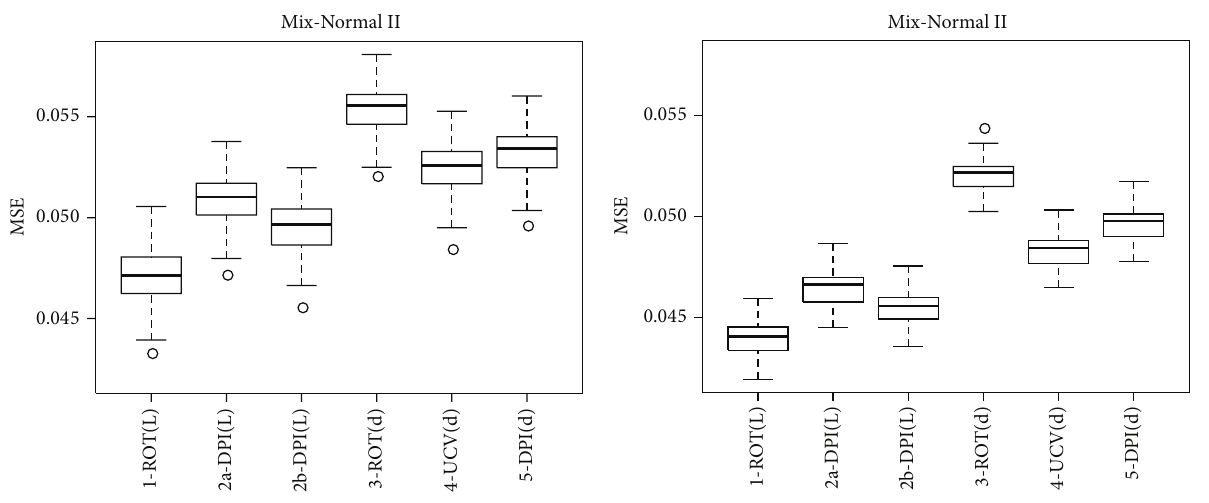
̂𝑈 Figure 7: The MSE of 2 in terms of bandwidth selection ̂ℎ ̂𝑔 ; “2b-DPI(L)” means with pilot bandwidth ̂𝑔 ROT ; density DPI ;𝑈 2 ̂ℎ DPI(d)” means DPI ; density